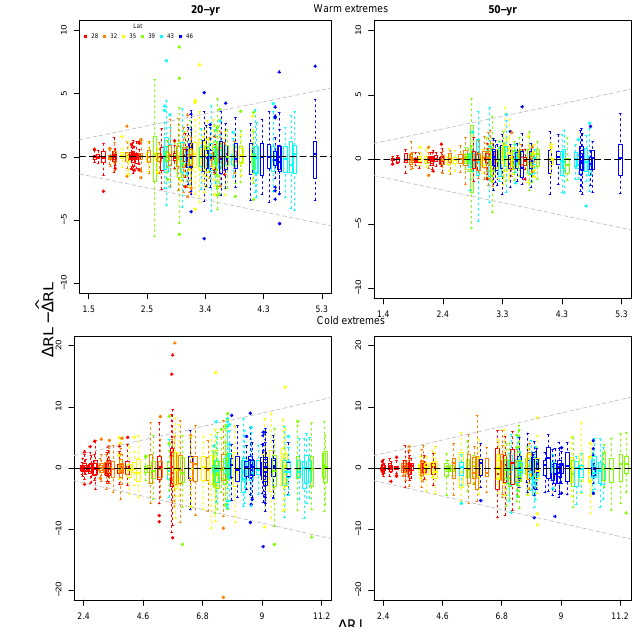
Figure 12. Assessment of sampling errors in estimates of return level changes using comparable data lengths for all model grid cells in the study area. Values shown are the estimated return level change minus the “ground-truth” change determined from the en- tire 1000-year segment ( (cid:49) RL − ˆ (cid:49) RL), plotted against the “ground- truth” change ( (cid:49) RL). Left: distribution (displayed as a boxplot) of estimates of changes in 20-year return levels made using 20-year segments. Right: the same for 50-year return levels and 50-year seg- ments. Top and bottom rows show warm and cold extremes. Gray reference lines are the 1 : 1 lines (i.e., sampling error = return level